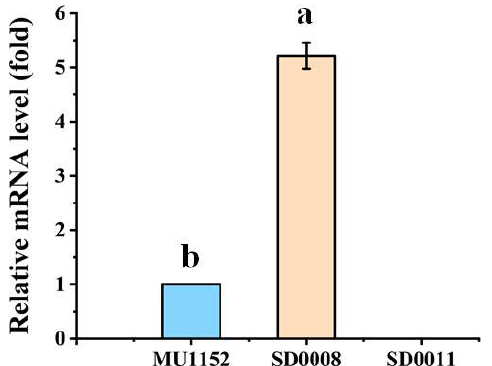
Figure 3. Transcription levels of the ada gene in the overexpressing strain SD0008, knockout strain SD0011, and the wide-type strain MU1152. Error bars represent the standard deviations. Different letters indicate significant differences, p < 0.05. For each group, three biological repetitions were